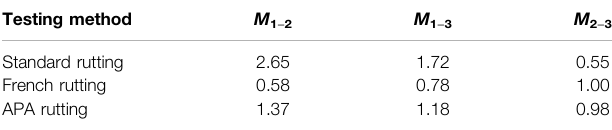
TABLE 7 | Closeness between laboratory rutting test results and fi eld test results. Testing